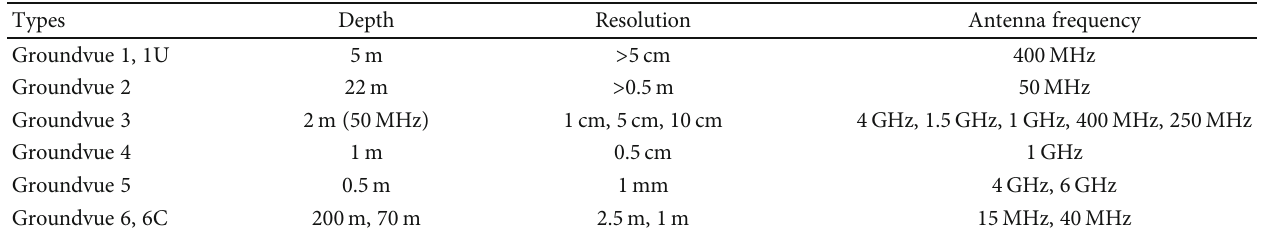
Figure 1: GPR antenna for Groundvue 2 (shielded (a)) and Groundvue 6 (unshielded (b)). Table 1: Main performance parameters of the GV series of geological